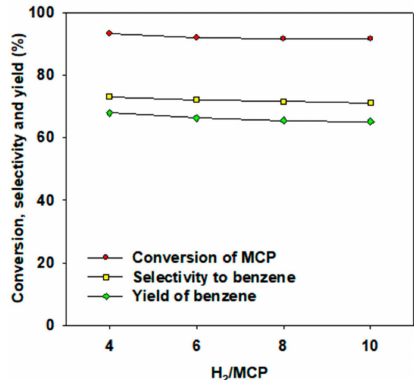
Figure 12. E ff ect of H 2 / MCP mole ratio on conversion, selectivity and yield over Pt / (HZSM-48 + pseudoboehmite,1:1) catalyst (reaction condition: pressure 1 atm, temperature 450 ◦ C, WHSV 0.3 h − 1 , and T-O-S 3